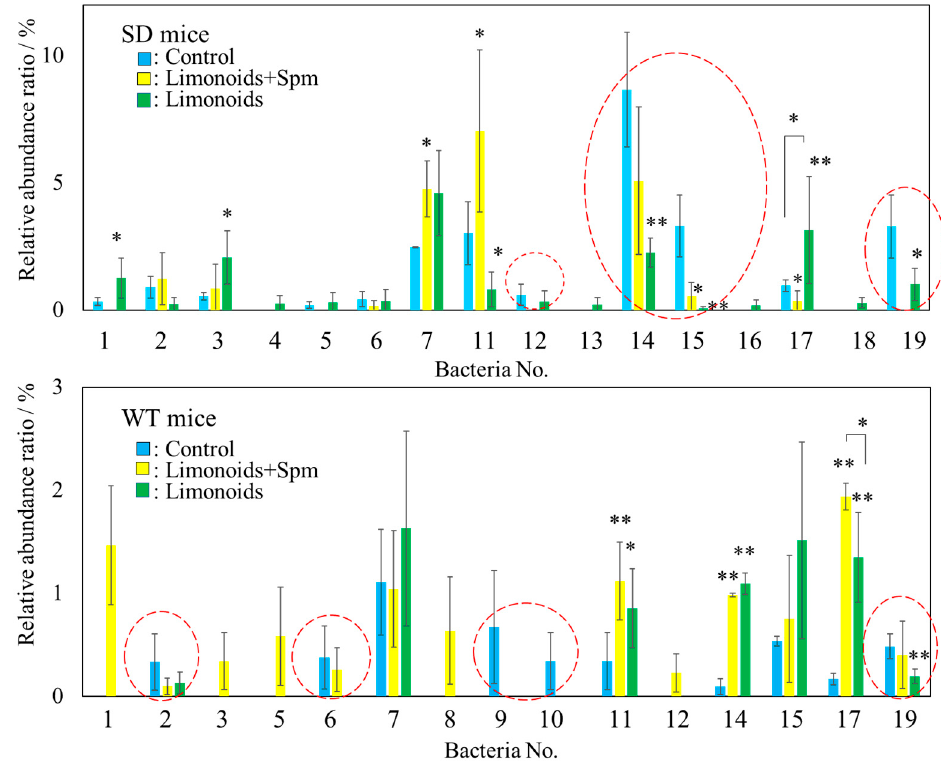
Figure 7. Comparison of the relative abundance (%) of bacteria at the genus level belonging to the Clostridiales order in feces for SD or WT mice. The bacterial numbers in the figure correspond to the bacterial numbers listed in Table 1. Bacteria whose relative abundance ratio was suppressed by feeding limonoids + Spm or limonoids alone are surrounded by a red dashed line. Values represent mean ± S.D. Data are plotted in comparison to the controls for clarity; * p ≤ 0.05; ** p ≤ 0.01. SD, Sandhoff disease; WT, wild-type.